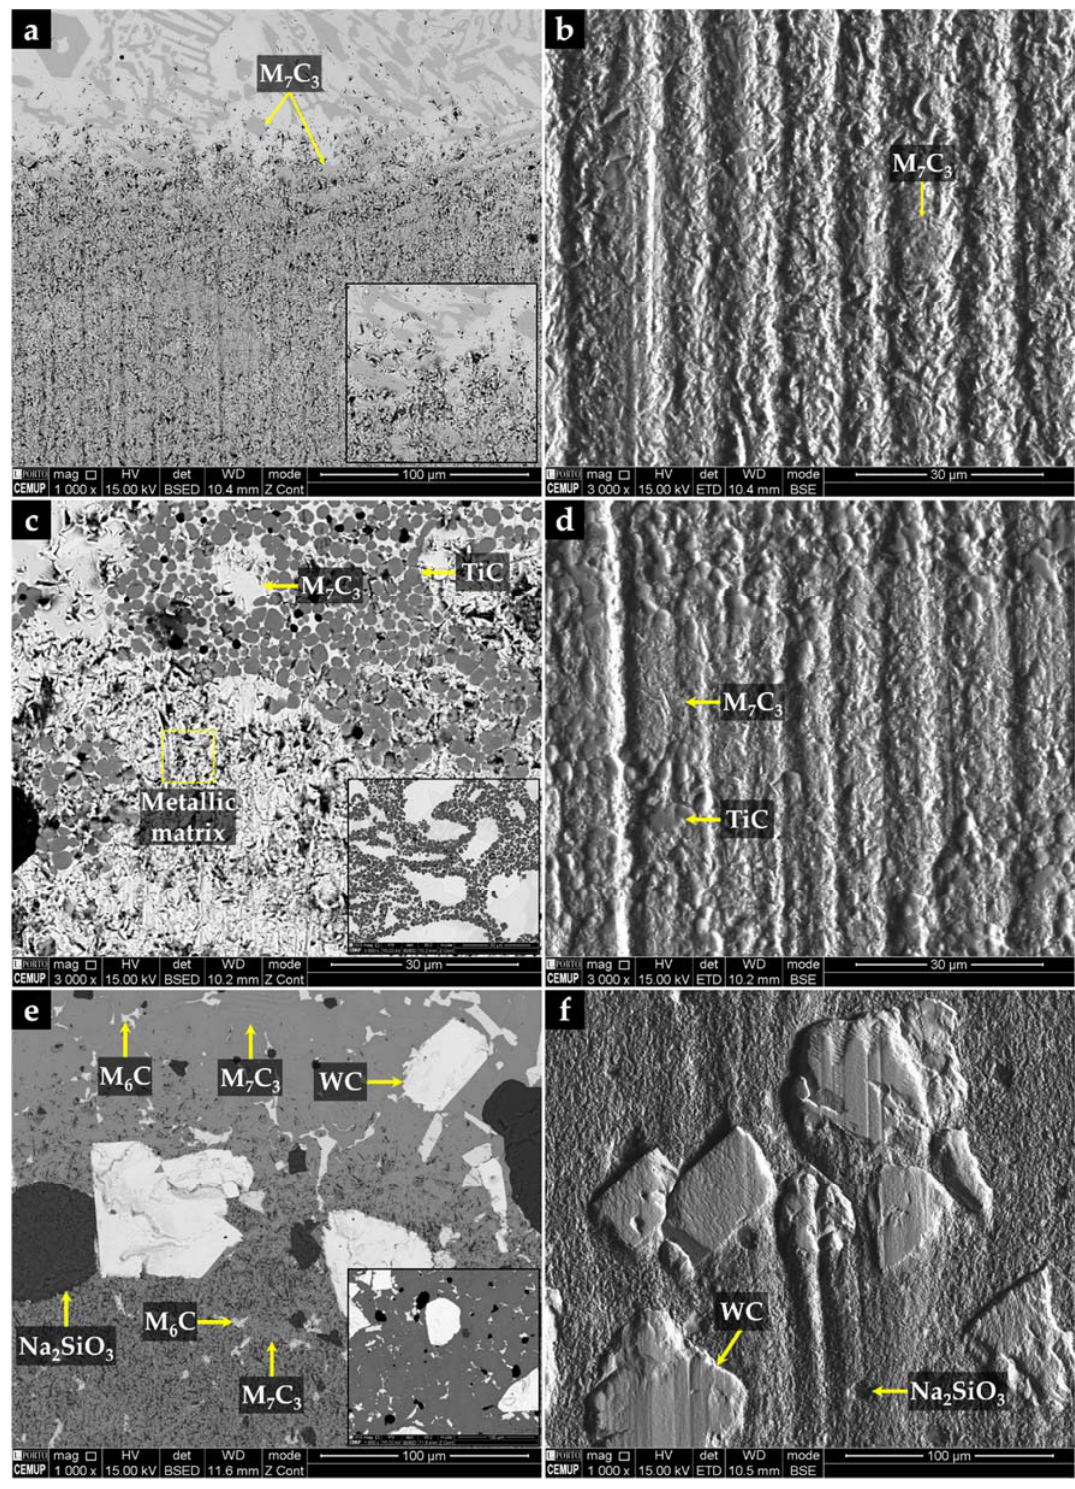
Figure 10. SEM images of the wear craters after a sliding distance of 39.3 m. ( a , b ) Base metal, ( c , d ) the TiC-WCI reinforcement, and ( e , f ) WC-WCI reinforcement; ( a , c , e ) show the regions close to the edge of the crater, and ( b , d , f ) show the regions on the surface of the crater.